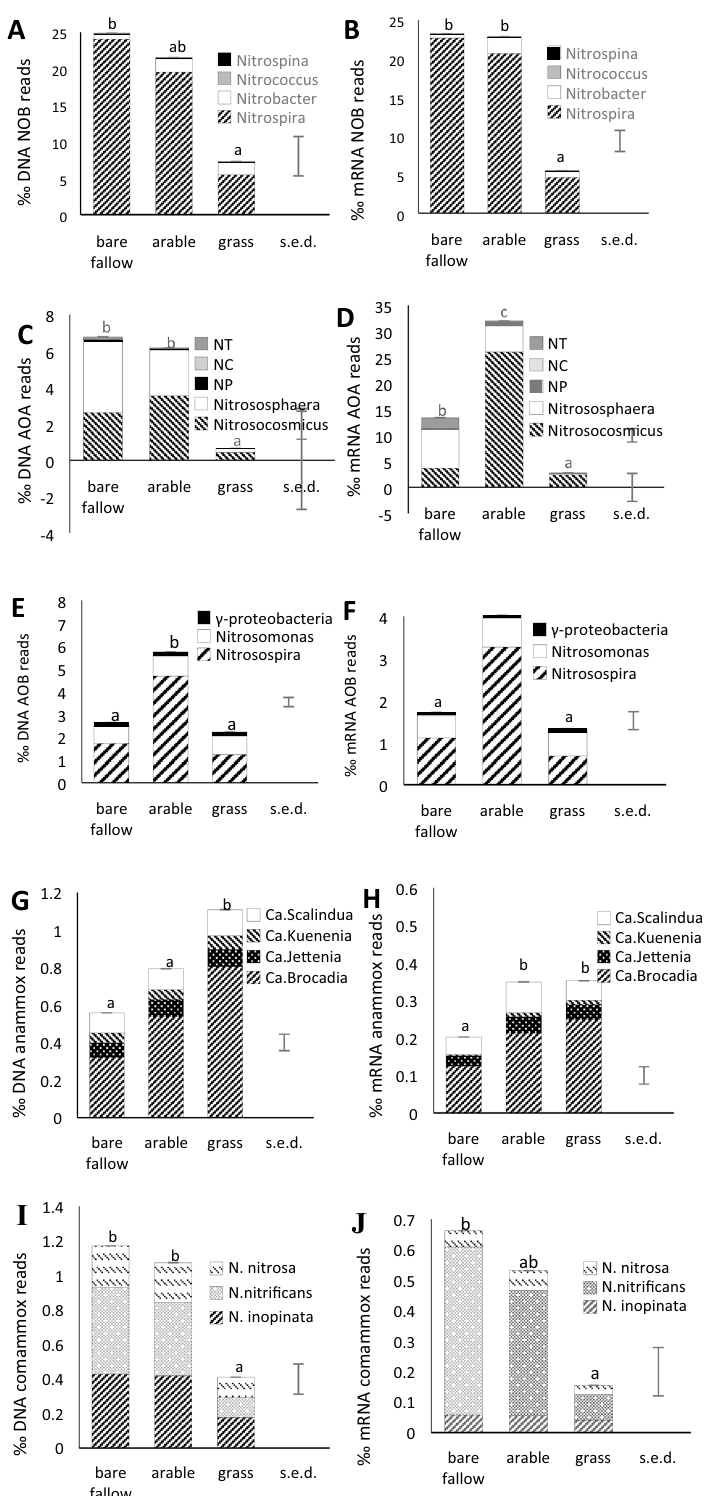
Figure 3. Mean proportion of DNA reads (left) and mRNA (right) reads assigned to the main nitrifying guilds shown in Fig. 2, expressed as per 1000 of total. The proportions formed by the component groups of each guild are shown (ANOVA statistics of component groups are shown in supplementary tables 1 and 2). Overall standard errors of differences of means (S.E.D.) are shown for each guild; different letters indicate significantly different means for each guild in each treatment. ( A , B ) – NOB; ( B , C )—AOA; ( E , F )—AOB; ( G , H )—anammox; ( I , J